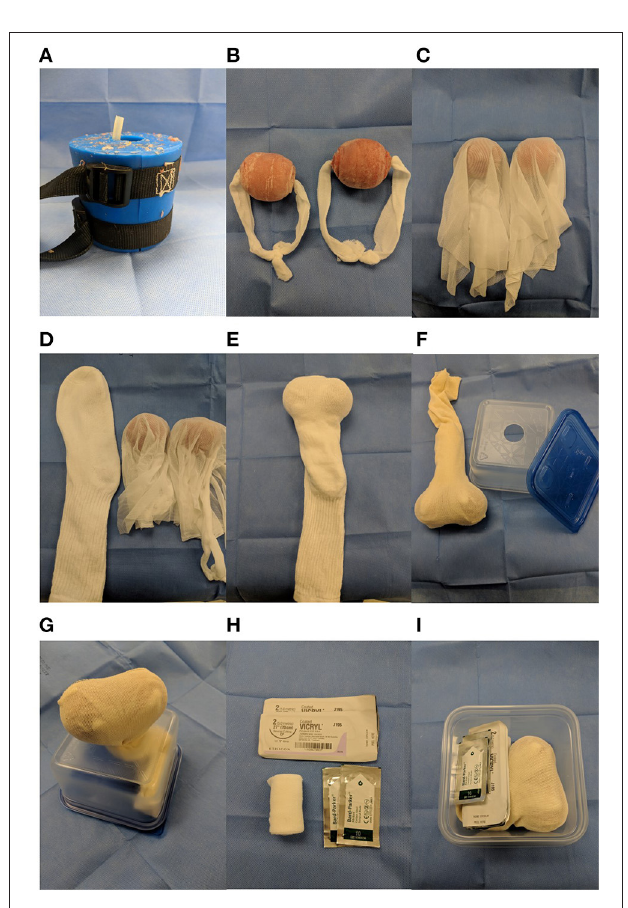
FIGURE 1 | Study design. As part of a third year course on equine veterinary field skills, students recorded themselves performing a “closed” castration on a low-fidelity equine model. The students also recorded two strengths and weaknesses as part of a self-reflection assignment. The student videos were independently scored by 2 different equine faculty using a proposed rubric. Also as part of the course, students were asked to complete 2 surveys before, and after, participation in field castration of a live horse. Following completion of the castration model activity, students received their rubric score. Following student data collection, veterinary experts were asked to evaluate the model via survey.